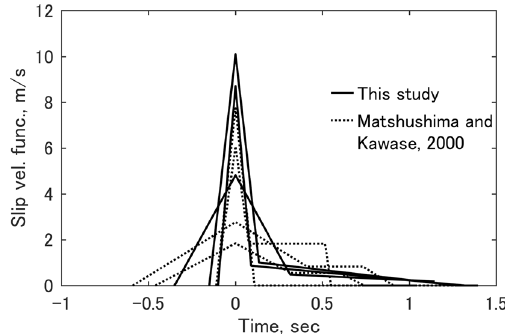
Fig. 11 Comparison of the slip velocity functions for 2016 Kumamoto earthquake (this study, solid lines) and for 1995 Kobe earthquake (Matsushima and Kawase 2000, dotted lines). All STFs are centered to their peaks. Wider STFs are for lager SMGAs in